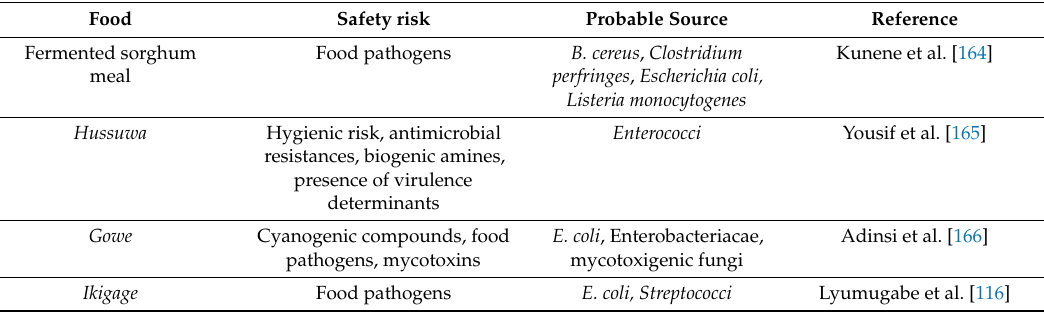
Table 6. Some recorded cases of pathogens in African fermented sorghum-based